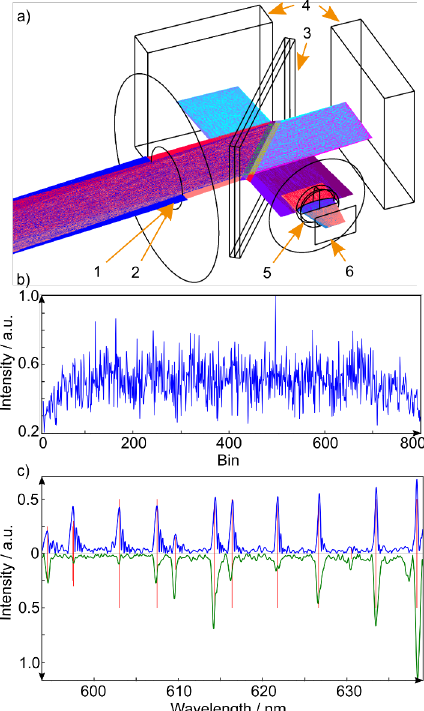
Figure 3: Simulation results: (a) Zemax model of a VIS- SHS, (b) interferogram of a neon spectral lamp, (c) mea- sured (blue) data, simulated (green) data with NIST refer- ence [5]